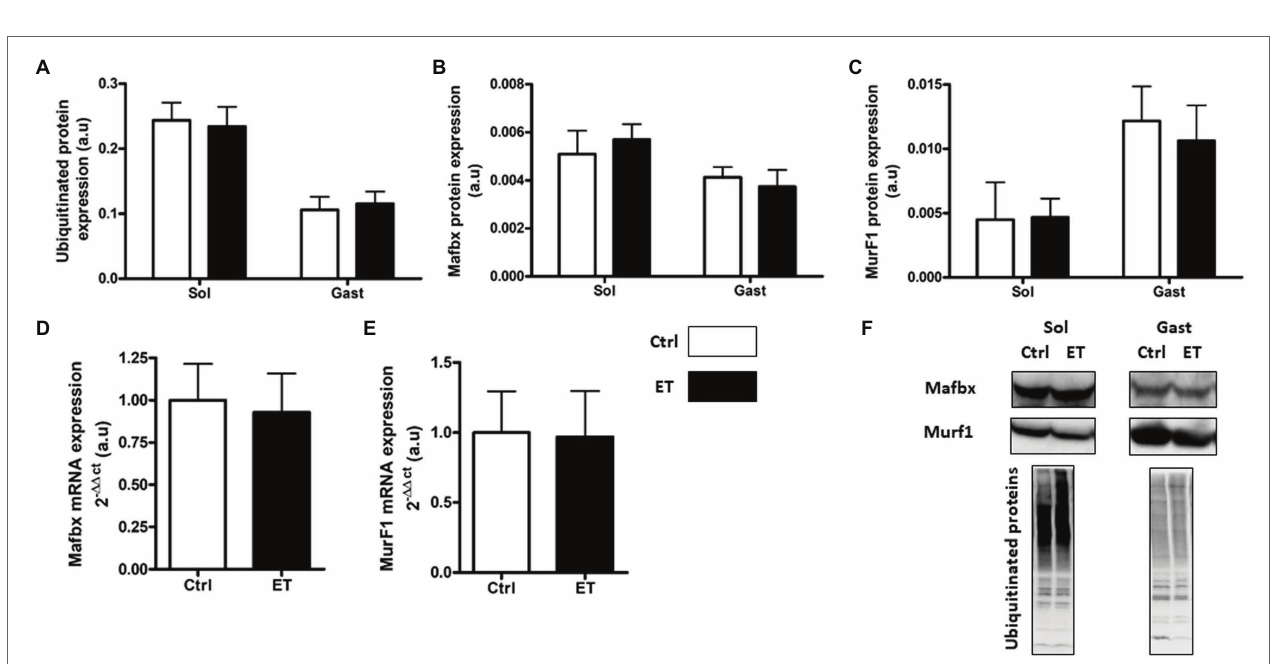
FIGURE 4 | Ergothioneine effect on transcription of protein synthesis markers. Expression of genes encoding protein synthesis markers in gastrocnemius samples ( n = 1/mouse). (A) IGF1 mRNA level. (B) Akt mRNA level. (C) Mtor mRNA level. (D) 4ebp1 mRNA level. (E) Rps6 mRNA level; * p < 0.05 vs. Ctrl.